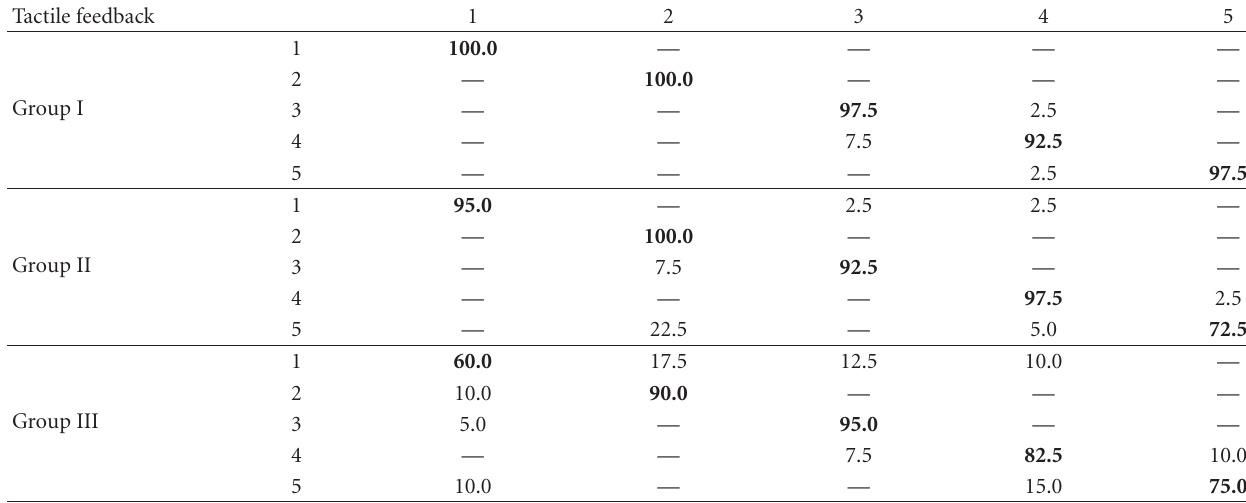
Table 5: Experimental results for tactile feedback